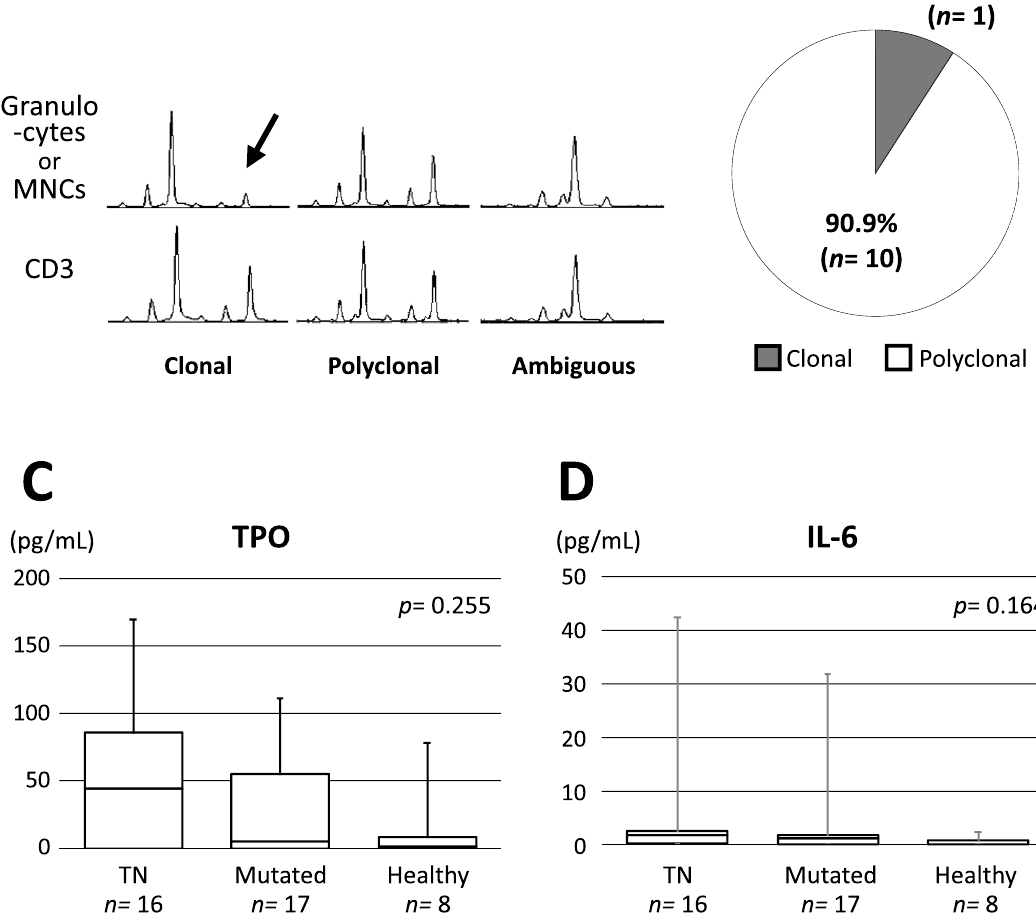
Figure 4. Polyclonal hematopoiesis in the TN-ET patients harboring comparable serum levels of cytokines for megakaryopoiesis. ( A ) Typical profiles of capillary electrophoresis of HpaII-digested gDNA from granulocytes (n = 10) or MNCs (n = 5) and CD3-positive cells. Two HpaII-resistant peaks representing maternal and paternal alleles in polyclonal hematopoiesis. One of these alleles becomes HpaII-sensitive in granulocytes, representing clonal hematopoiesis (arrow). ( B ) A pie chart presenting the frequencies of clonal and polyclonal hematopoiesis judged by the HUMARA assay in TN-ET. Four of 15 patients who exhibited ambiguous patterns in the HUMARA assay ( A ) were excluded from the analysis. Comparison of TPO ( C ) and IL-6 ( D ) concentrations in the serum among the patients with TN-ET, patients with ET harboring driver mutations, and healthy